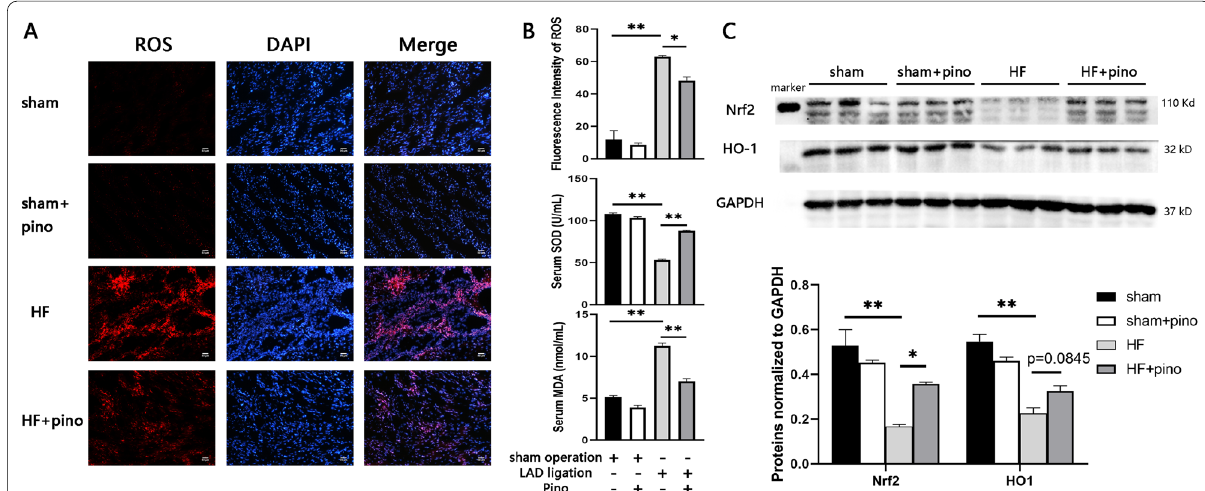
Fig. 4 Pinocembrin ameliorated post-infarct heart failure-associated oxidative stress. A – C ROS detection, biochemical examinations and western blot results indicated that pinocembrin could scavenge ROS and facilitate antioxidant defense in a Nrf2/HO-1 signaling pathway-dependent manner. *p < 0.05; **p < 0.01. ROS reactive oxygen species, Nrf2 nuclear factor erythroid 2-related factor 2, HO-1 heme oxygenase-1